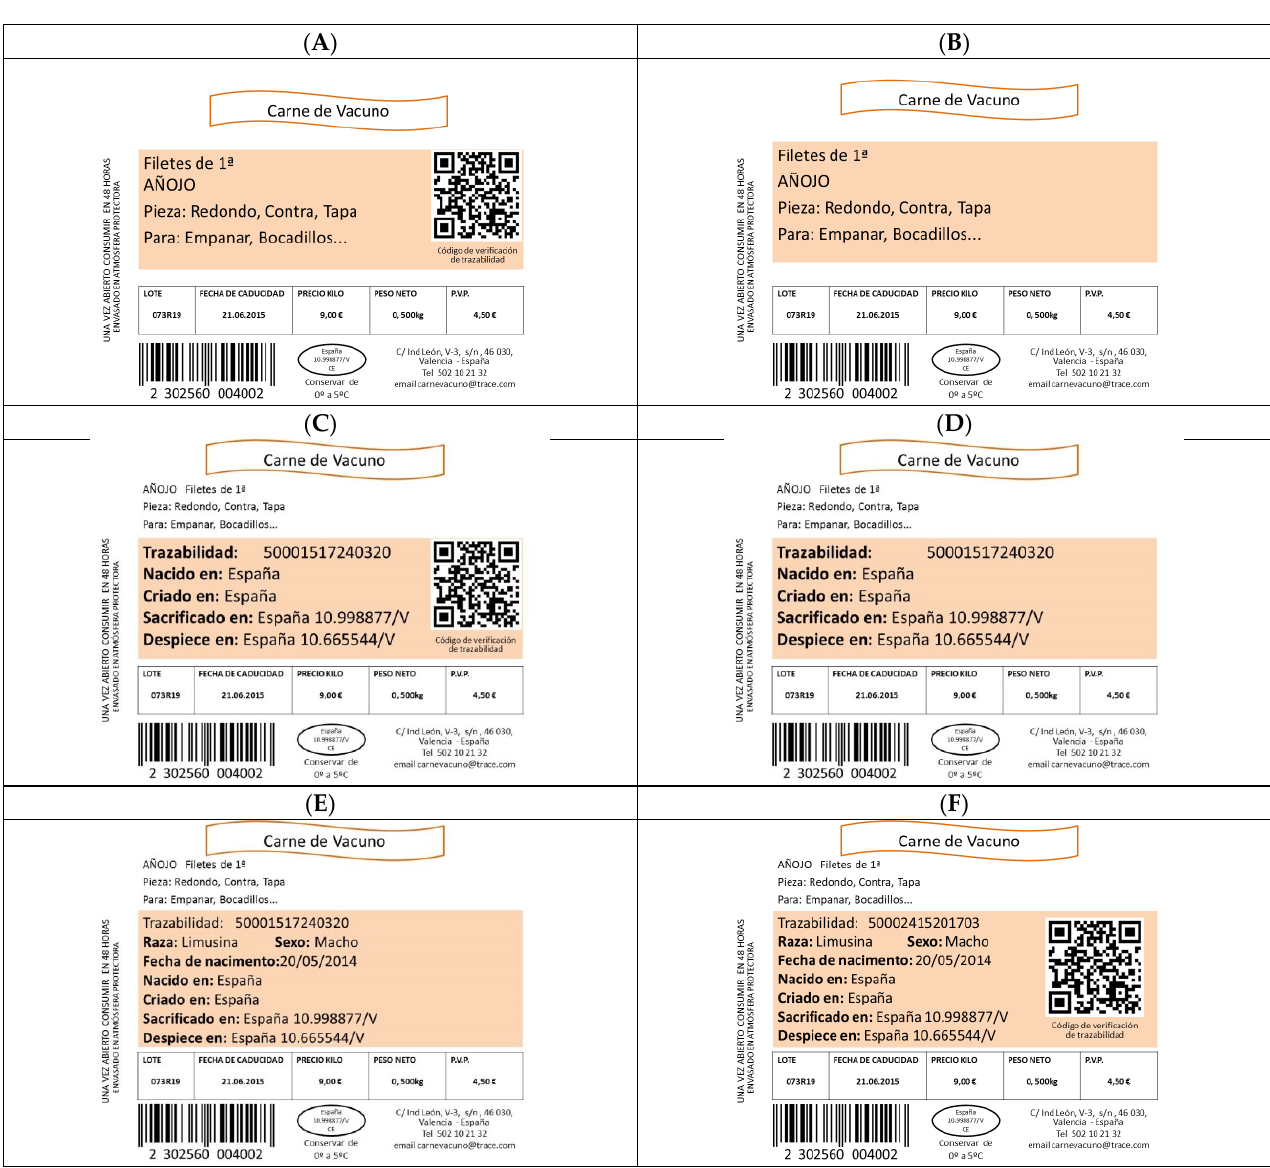
Figure A1. ( A )—Traceability information available on the label: QR Code. ( B )—Label without traceability information